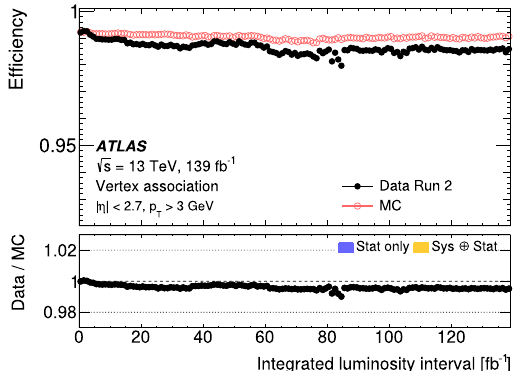
not displayed. The panel at the bottom shows the ratio of the measured to predicted efficiencies, with statistical and systematic uncertainties. Stable efficiencies are reached during 2017, after 60 fb − 1 of collected data, and maintained until the end of Run 2, with some fluctuations at the beginning of 2018 corresponding to collision runs with high pile-up